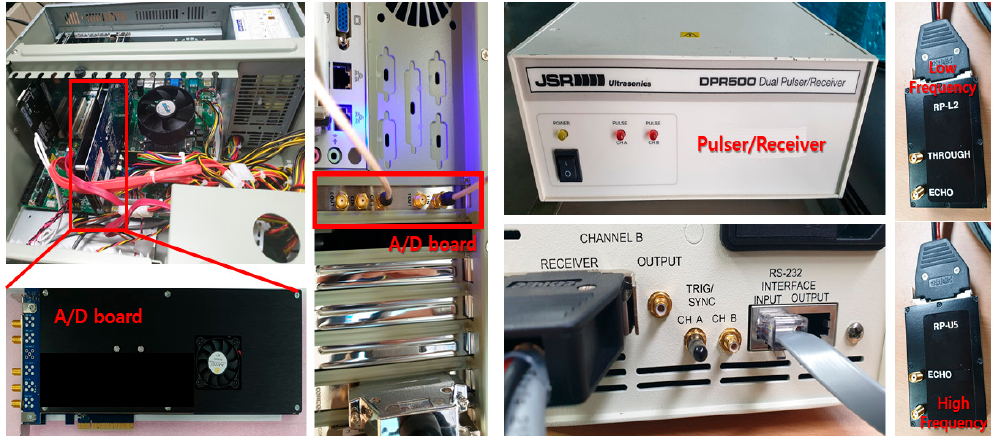
6 of 13 Figure 5. X-axis performance verification. 3.2. Activation Module and Data Acquisition System For the activation module, JSR Ultrasonics’ DPR 500 Dual Pulser/Receiver, which can simultaneously excite high-frequency (up to 500 MHz) and low-frequency bands, was in- stalled. DPR 500 can excite both low-frequency and high-frequency bands. In the case of the data acquisition system, the compatibility with the activation module is the most im- portant factor. The analog data of the high-resolution acoustic microscope must be con- verted into digital data, and Gage’s TB3-ENE126G10 A/D digitizer was selected to de- velop optimal software. It was selected because it can be installed in industrial computers built in PCI board format. Figure 6 shows the images of the constructed activation module and data acquisition system. The activation module was composed of the pulser/receiver